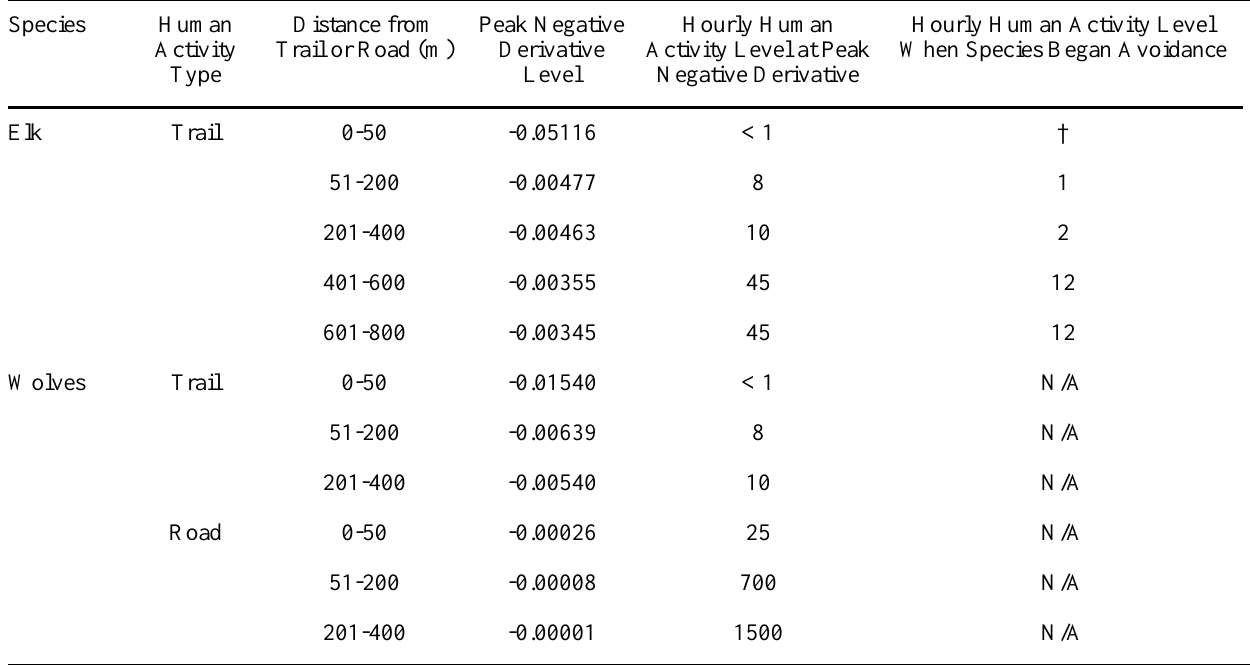
Table 2. Hourly human activity at the peak negative derivative. ‘Peak derivative level’ represents the greatest rate of negative change in probability of use of locations within listed distances-to-trails/roads. Distance-to-trail/road categories that did not have negative derivatives were not included. † = Derivative was continuously negative. N/A = Not